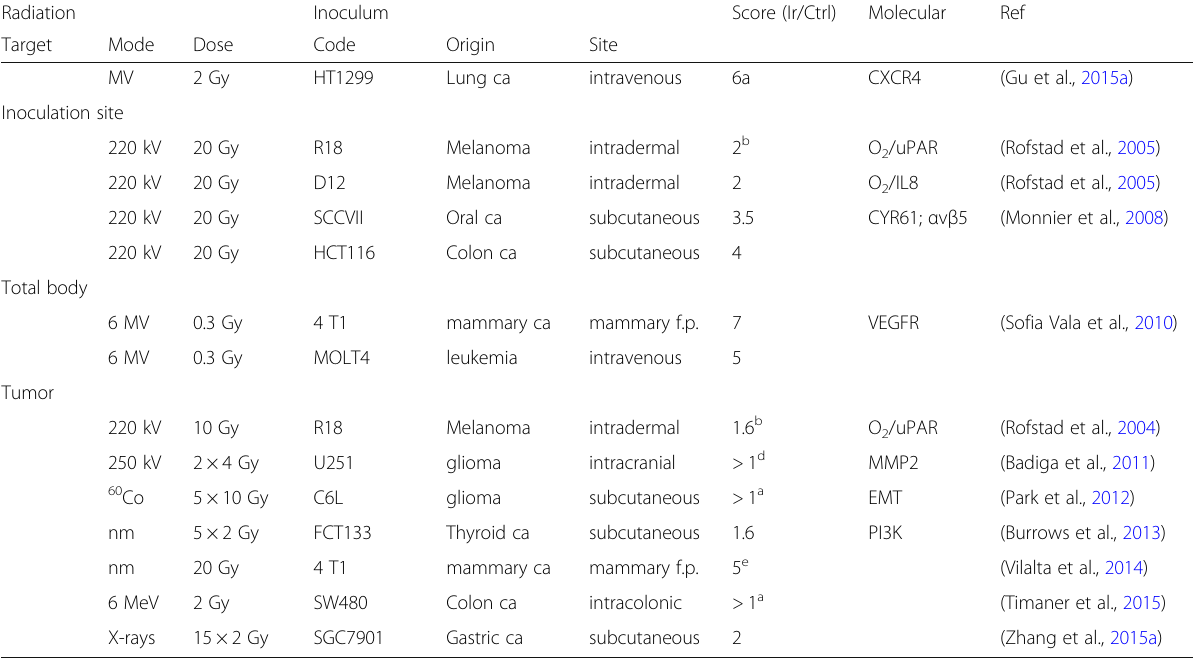
Table 3 Effect of radiation on local invasion or metastasis of rodent and human cancer cell lines as tested in syngeneic and in xenogeneic mice respectively